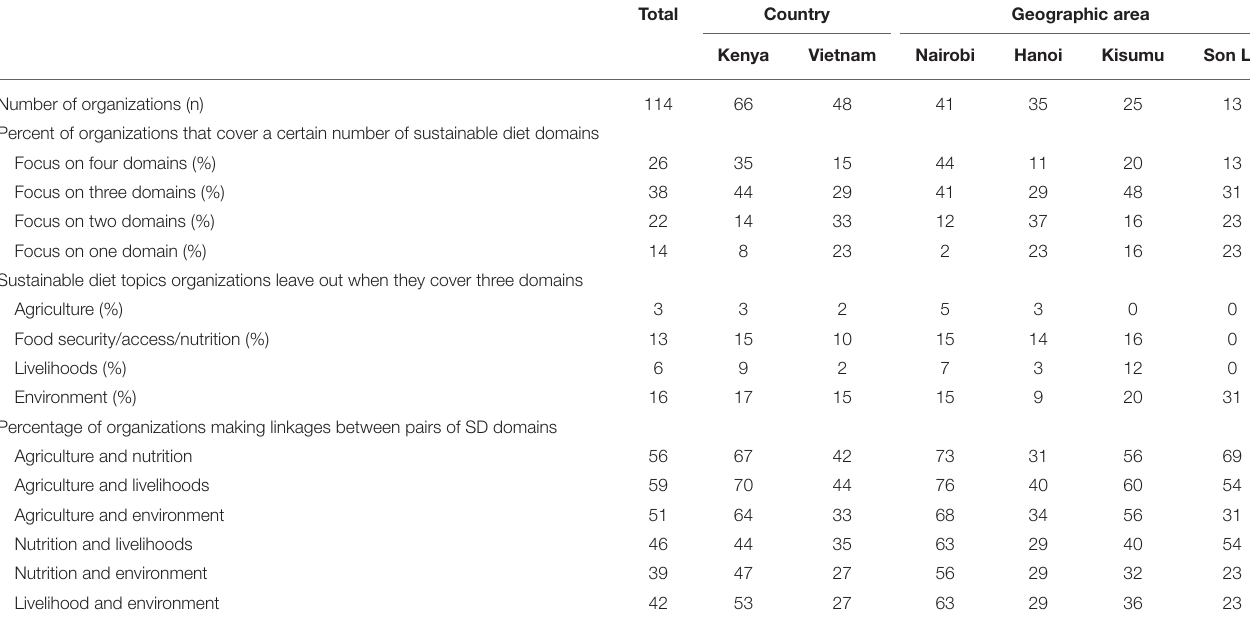
TABLE 2 | Percentage of organizations that cover sustainable diet domains, by country and geographic area.